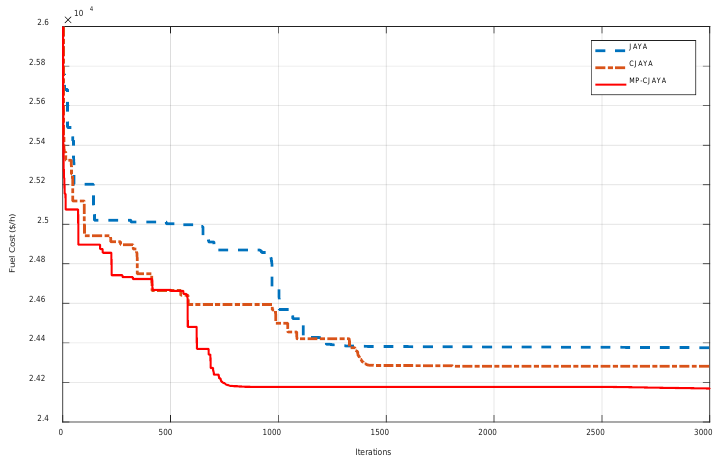
Figure 4. Fuel cost convergence characteristic of 13-units system ( P D = 2520 MW).